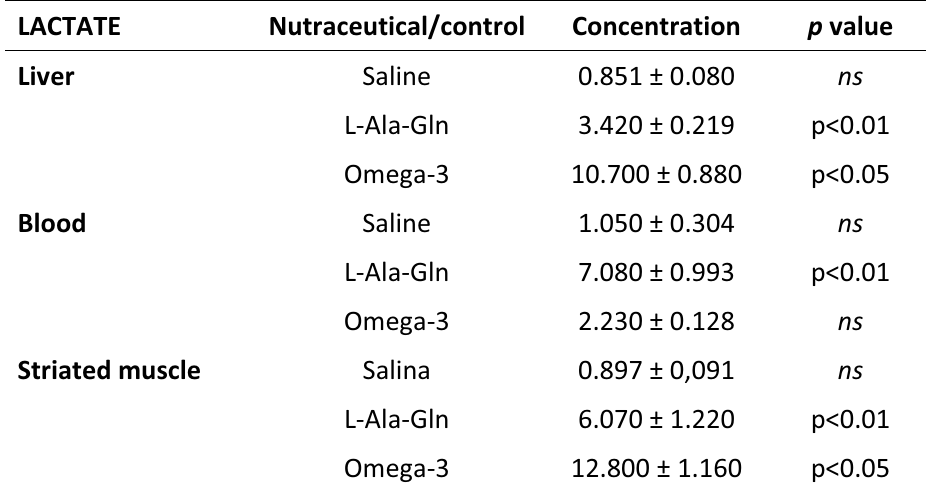
TABLE 2 - Mean lactate concentrations in the blood (µmol/ml) and tissue (mol/g) in groups G1 - treated with saline, G2 - treated with L-Ala-Gln and G3 - treated with Omega-3, 48 hours after sepsis